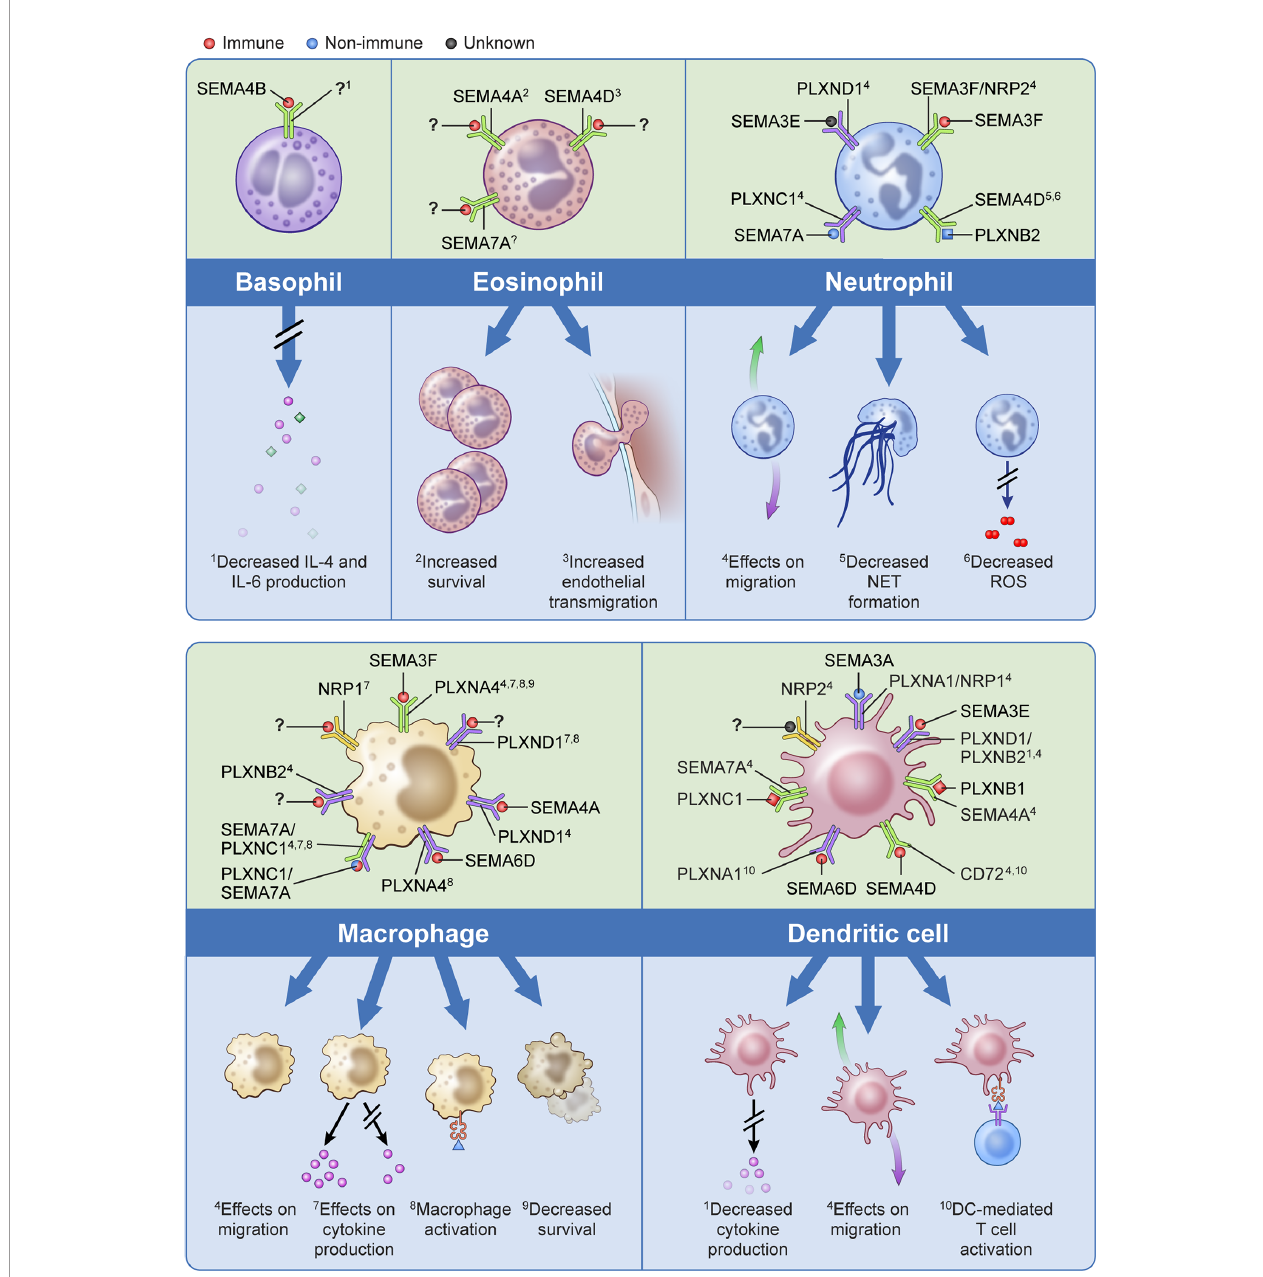
FIGURE 1 | The effects of semaphorins and their receptors on cells of the innate immune system. Semaphorins and their binding partners in relation to innate immune cells are shown here. Ligands depicted in red have been shown to originate from immune cells, those in blue from non-immune cells, and for those depicted in black the cell of origin is unknown.? indicates unknown ligand for the depicted receptor. Superscripts are related to the processes described in the lower part of the panels for each cell type; ? indicates that a speci fi c function has not been associated with the interaction